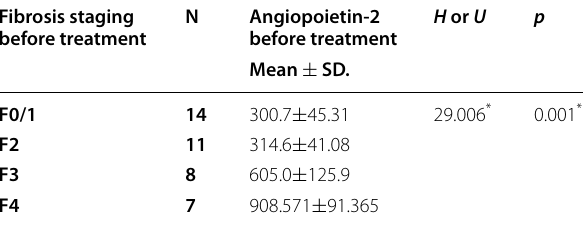
Table 4 Relation between Angiopoietin-2 and fibrosis staging before treatment